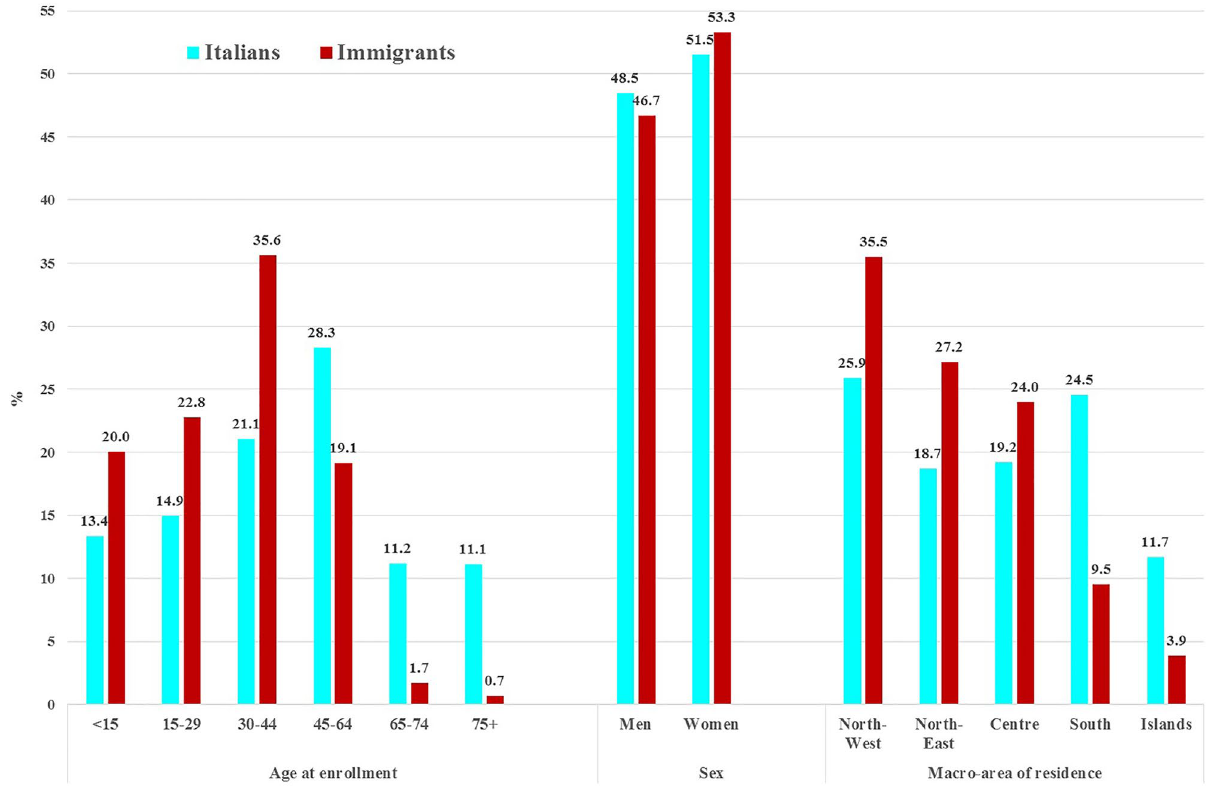
Figure 1. Differences between Italians and immigrants in the distribution of the sociodemographic